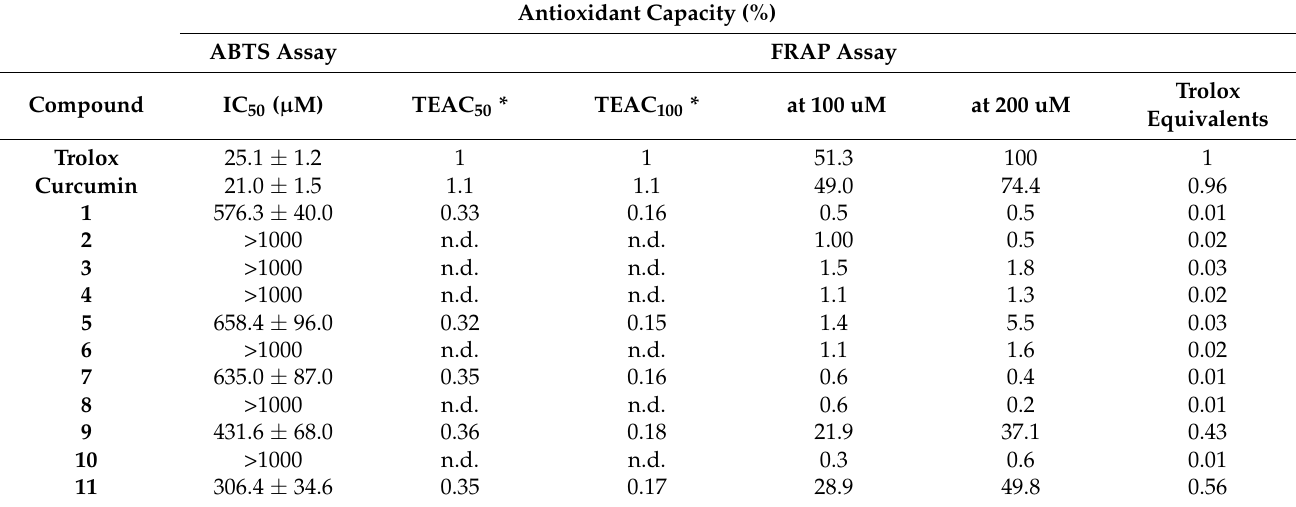
Table 1. Antioxidant properties of